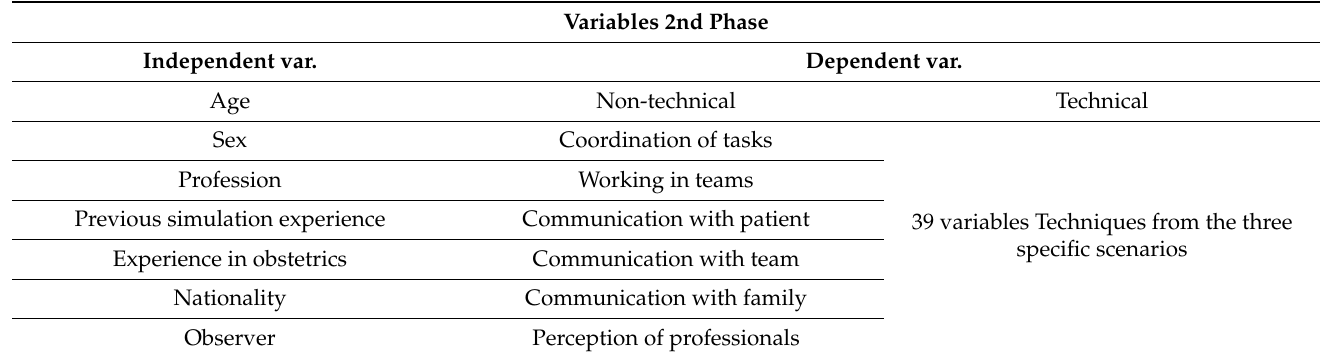
Table 1. Variables of the second phase of the